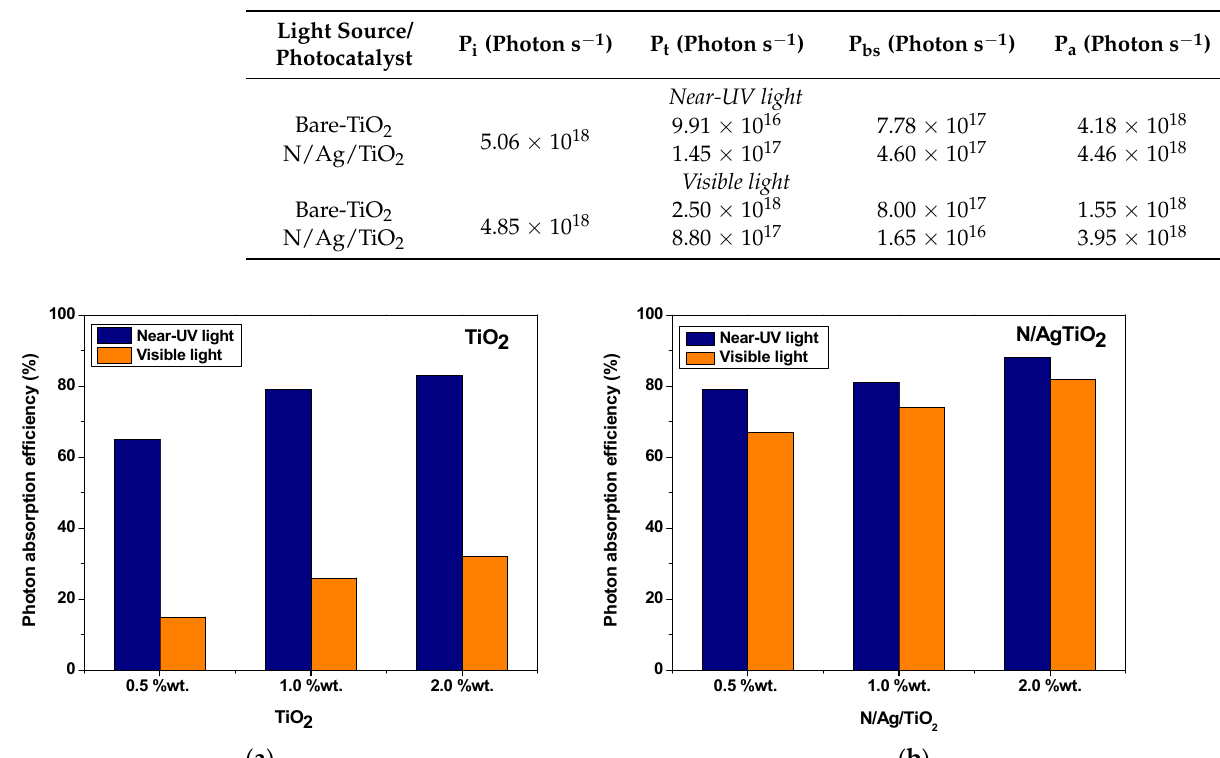
Table 4. Calculated photon fluxes of incident light (P i , r = 5.9 cm), transmitted light (P t , 5.25 cm) and backscattered light (P bs , r = 7.7) by the coated mesh. All occur when using the woven mesh coated with 2 wt.% of photocatalyst loading under either near-UV (320–380 nm wavelength) or visible light (380–700 nm wavelength).